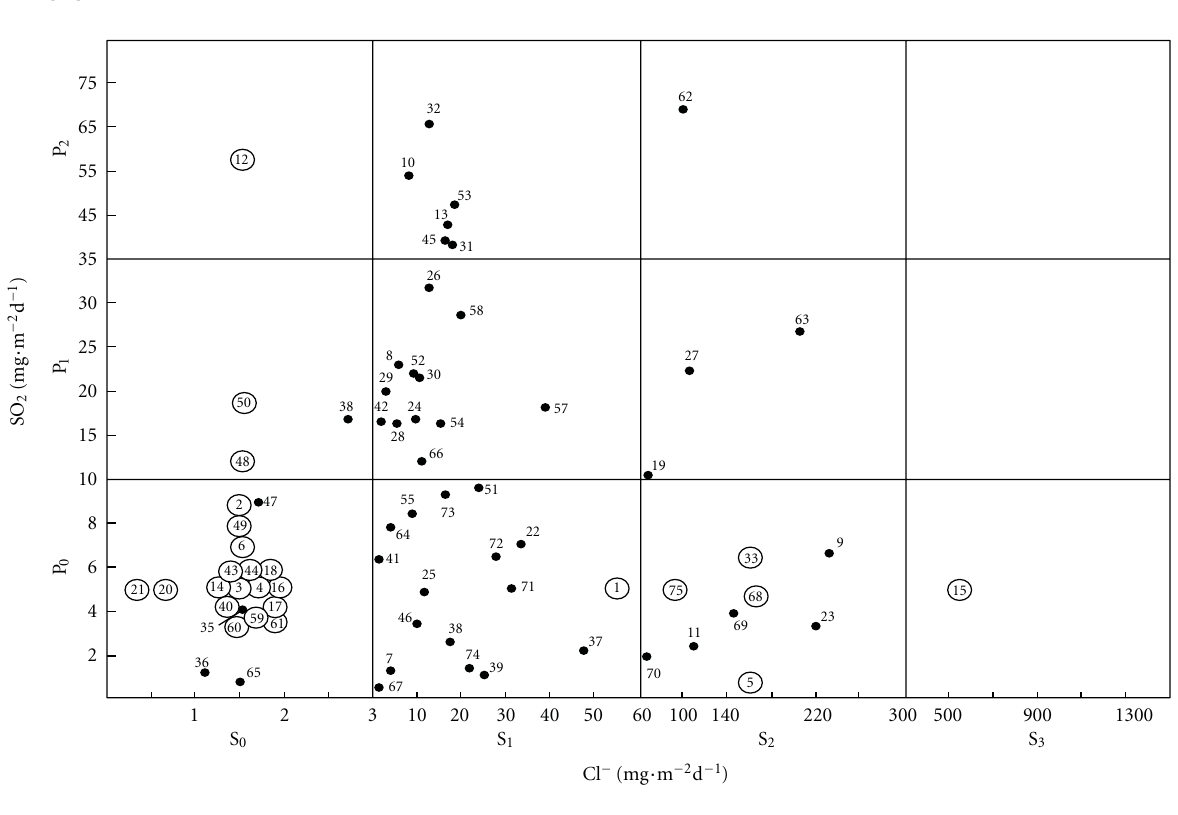
Figure 2: Classification of the test sites, according to ISO 9223 [24] and based on the SO 2 and Cl − deposition rates (average of the first three years of exposure in the atmospheres). The test sites where the deposition rates have been estimated are surrounded with a